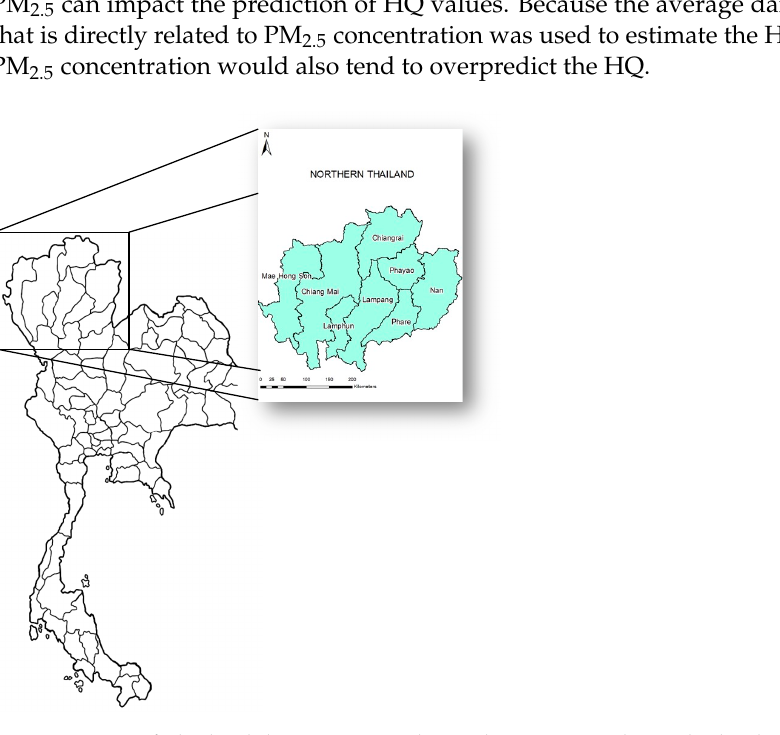
Figure 1. Map of Thailand demonstrating the study area in northern Thailand.